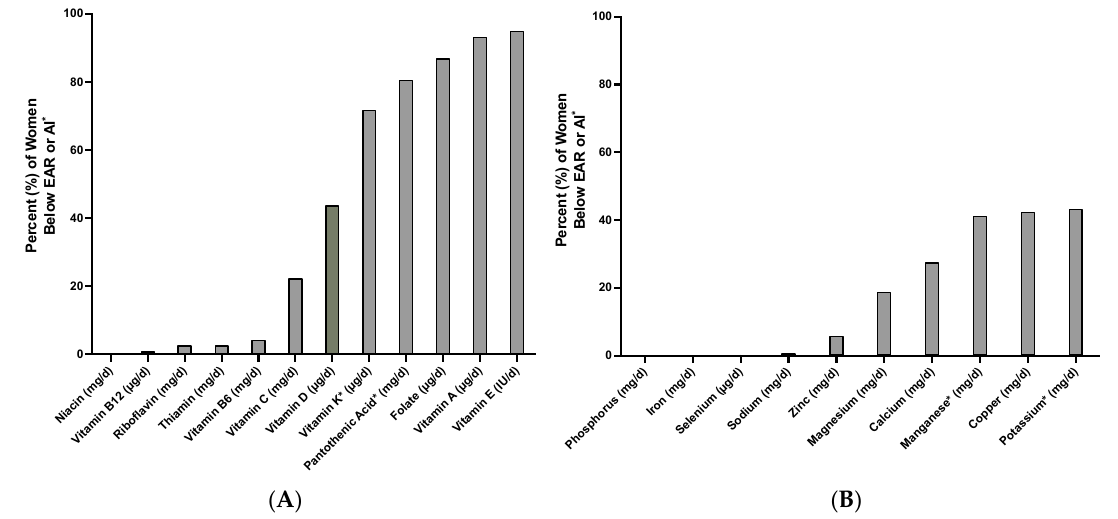
Figure 1. Percent of Hispanic women ( n = 188) below the estimated average requirement (EAR) or adequate intake (AI) values for ( A ) vitamins and ( B ) minerals from 1 to 6 months postpartum. EAR and AI values come from the National Institutes of Health (NIH) for lactating women 19–50 years old. * EAR values have not been established for these nutrients, so adequate intake (AI) values were used.